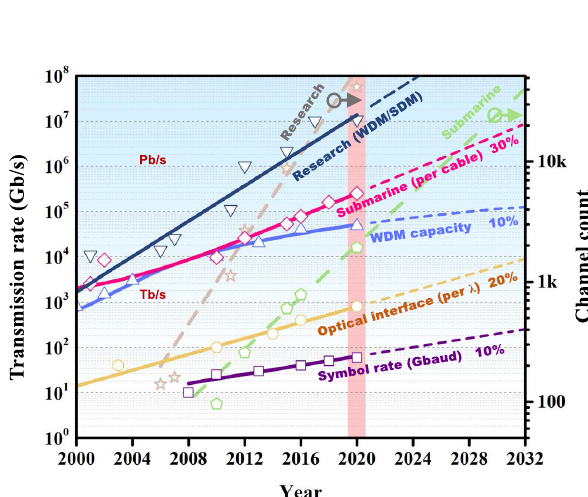
Figure 1: Evolution of fiber-optic transmission capacity. The channel counts are estimated based on the product of amounts of wavelengths and spatial paths. The data of commercial systems (including symbol rate, optical interface, WDM capacity and submarine systems) are extracted from [1, 10] for 2000 – 2018 and from [11, 12] for 2019 – 2020. The lab research results are extracted from [13 – 20]. WDM,